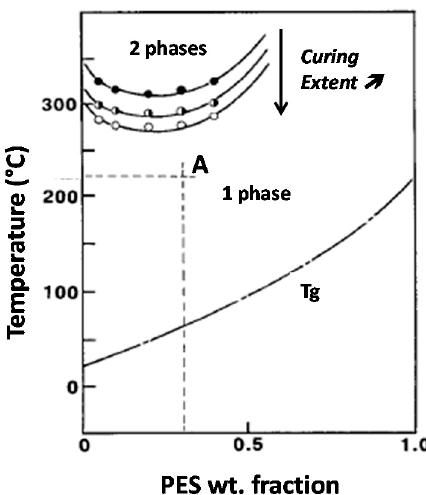
Figure 1. Phase diagram and initial vitrification curve of an epoxy-PES blend (LCST behavior). Critical solubility temperature decreases when curing extent increases. For instance, blend A is initially liquid and homogeneous will phase-separate upon curing.